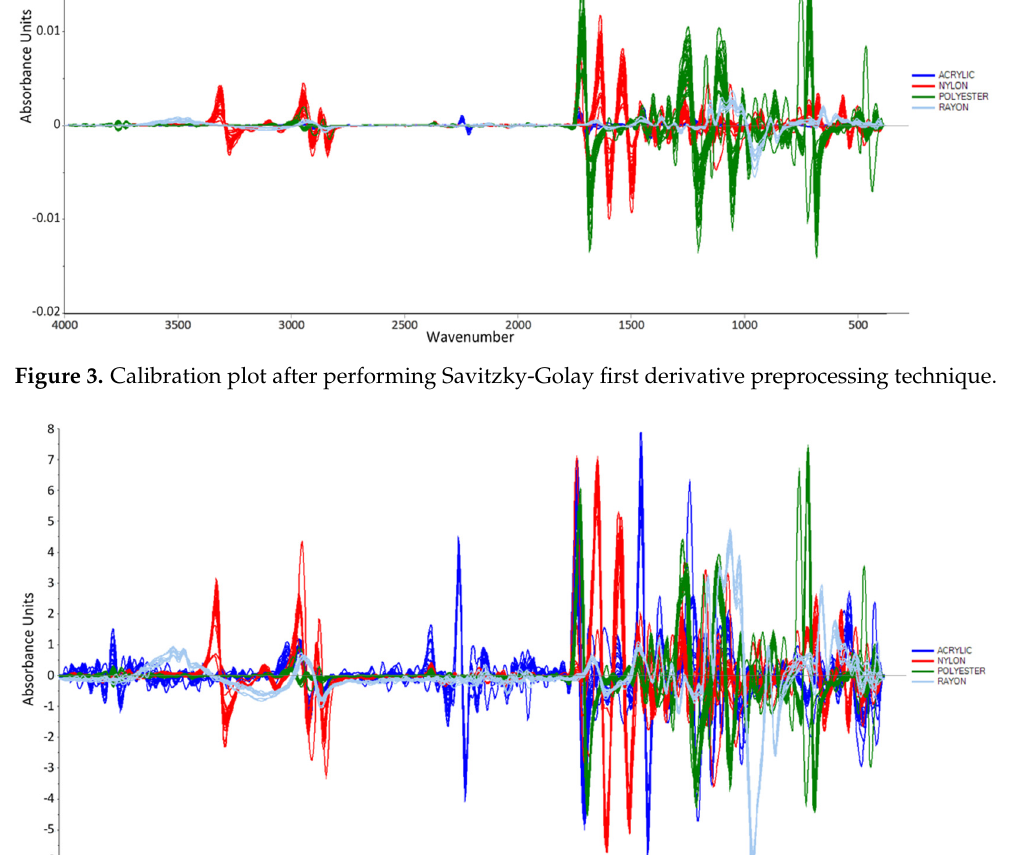
Figure 4. Calibration plot after performing Savitzky-Golay first derivative followed by SNV tech- nique.